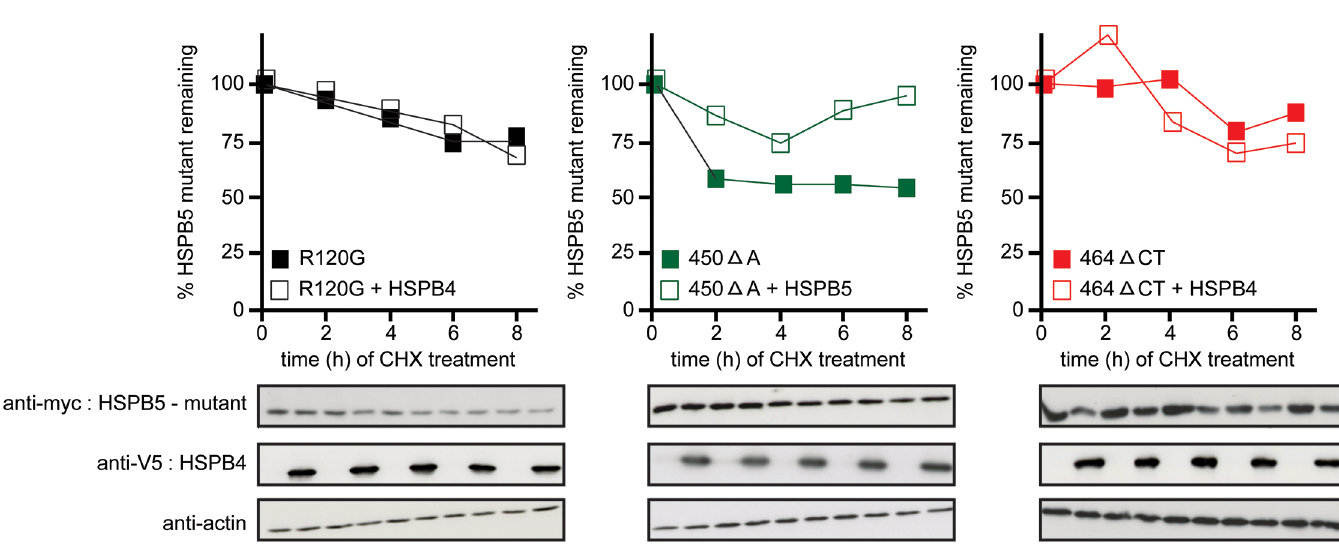
Fig 2. HSPB4 does not accelerate the degradation of HSPB5 mutants. HEK293 cells were co-transfected with myc-HSPB5 mutants (R120G, 450 Δ A, 464 Δ CT) and HSPB4-V5 or FRTTO as a control at 1:3 ratio. After 24 h, cells were treated with cycloheximide (50 μ g/ml) for the indicated time points. Cells were lysed in SDS buffer and total lysates were collected. SDS-PAGE and western blotting were performed. The quantification of 3 independent experiments is depicted in the chart above each blot where each value was first normalized to its loading control then normalized to 0 time point.